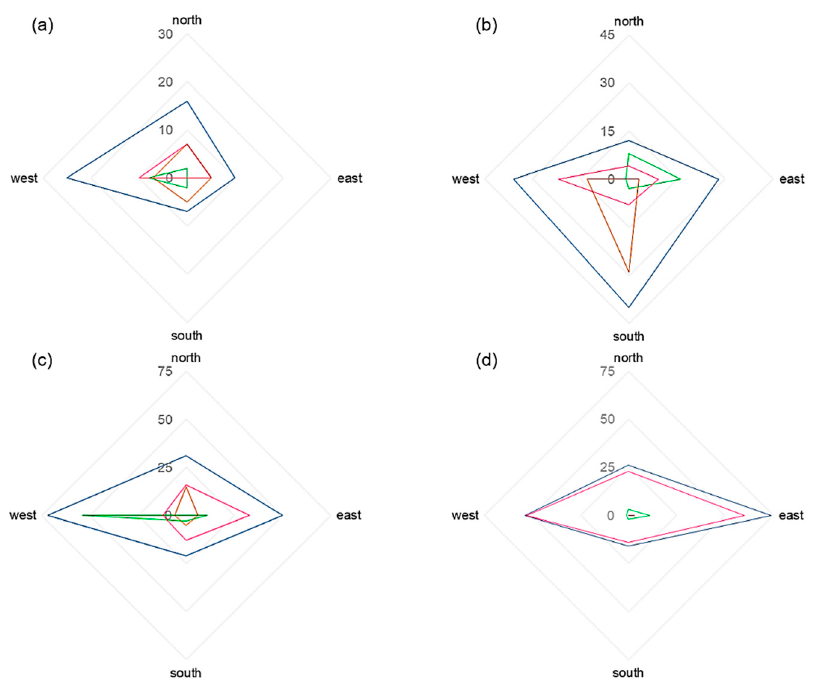
Figure A3. Pollen impaction (pollen grains/cm 2 ) on the vertical slides in 2019 for the pollen seasons; pre-pollen season: 18.03–02.04 (green), main pollen season: 02.04–23.04 (pink), post-pollen season: 23.04–14.05 (brown) and total (blue). For pollen traps 1 ( a ), 2 ( b ), 3 ( c ) and 4 ( d ) at the location Schorndorf.